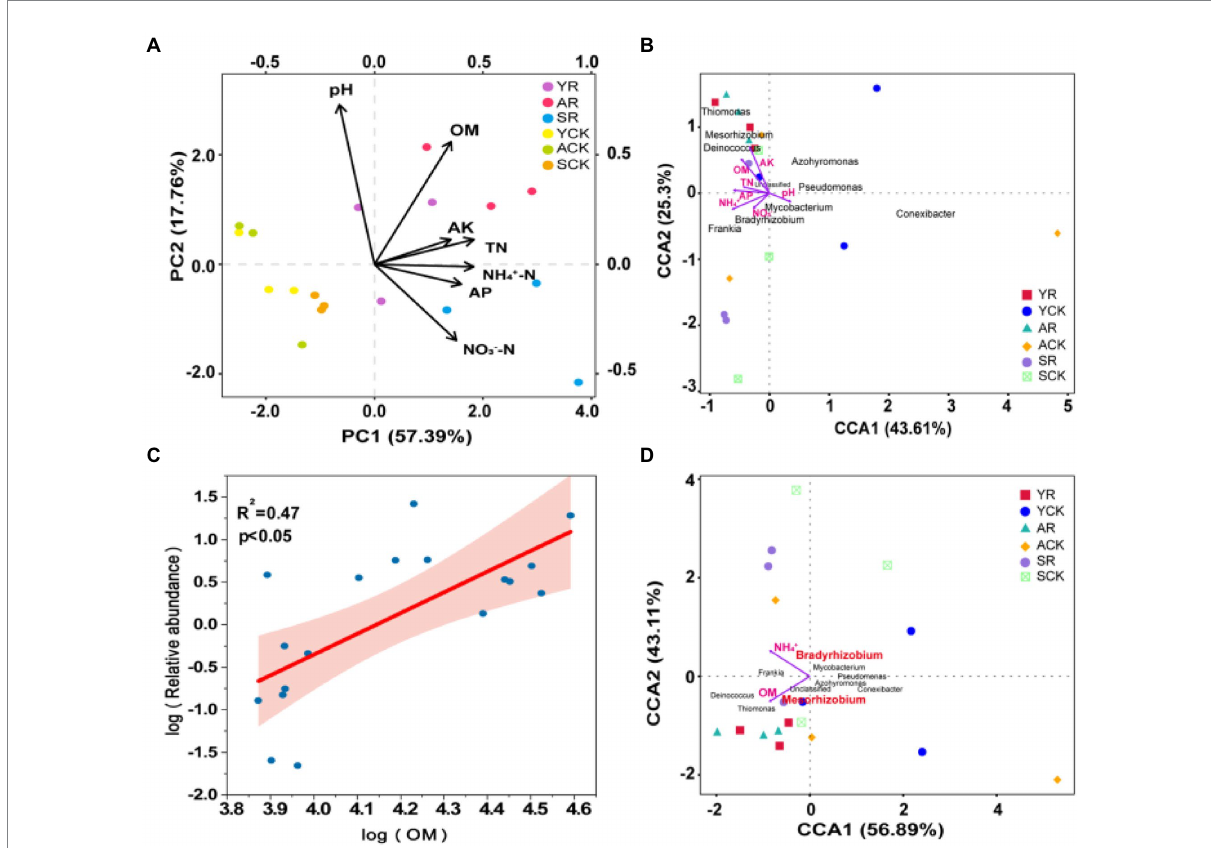
FIGURE 4 (A) PCA analysis based on soil physical and chemical properties. (B) CCA analysis of the nif H community and soil environmental factors in rhizosphere soil and bulk soil. (C) Linear regression relationships between the relative abundance of Mesorhizobium and the contents of OM. The relative abundance and contents were log transformed, and shading around regression fits in D are 95% confidence intervals for true fitted values. (D) CCA analysis of the nif H community and soil environmental factors in rhizosphere soil and bulk soil after BioENV analysis of environmental